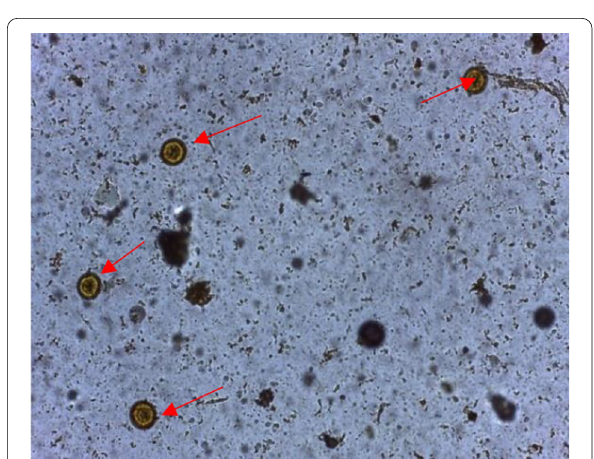
Fig. 4 Eggs of Taenia sp .